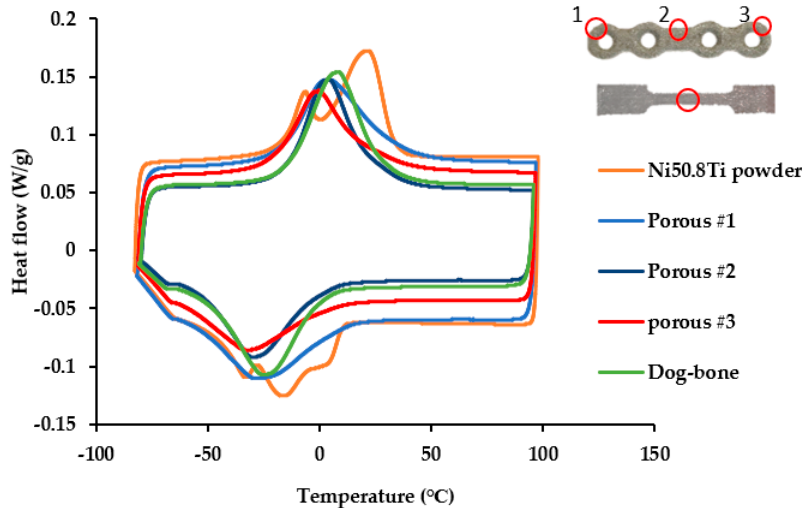
Figure 7. The differential scanning calorimetry (DSC) results of the as-fabricated porous bone fixation plate from three different locations, the dog bone sample, and Ni50.8Ti powder.